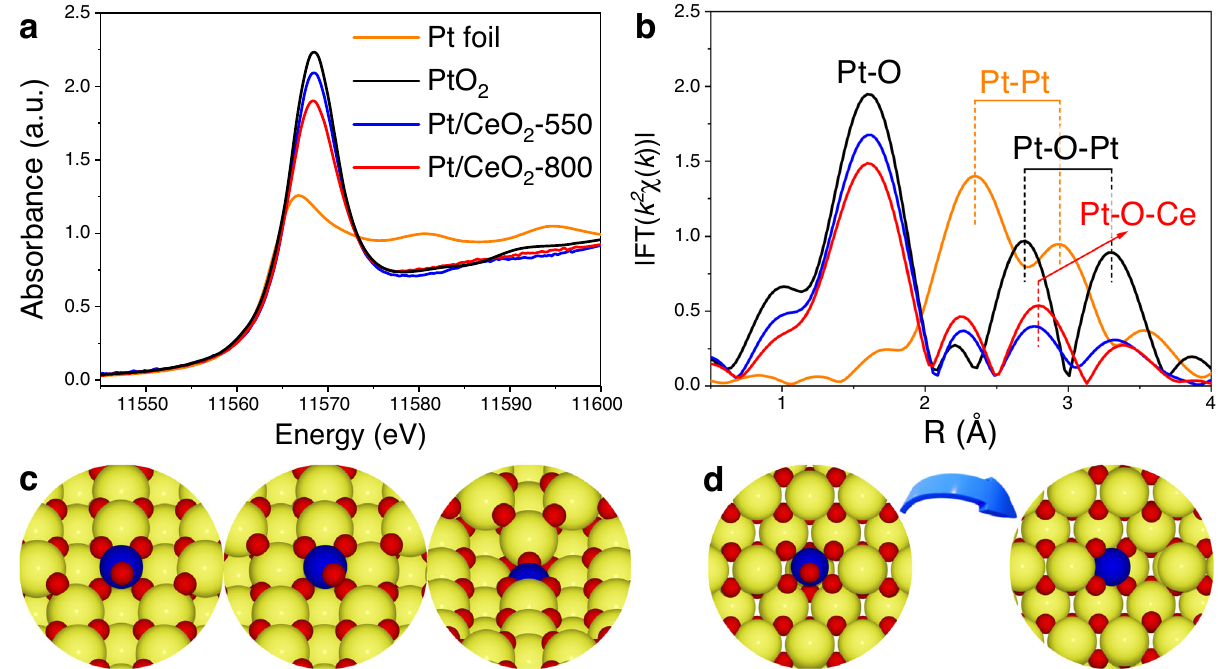
Fig. 4 | Coordination environment of Pt single atoms determined by XAS combination fi tting and EXAFS comparison. c Three possible geometries of Pt analysis.a Normalized XANESand b EXAFS magnitudeof the Fourier transformed single atoms at the edge or step sites on CeO 2 (110) within Pt/CeO 2 -550. d The k 2 -weighted χ ( k ) data for Pt/CeO reconstructionofPtsingleatomsonCeO 2 (110)terrace fromsix-coordinationsites 2 -550 (blue) and Pt/CeO 2 -800 (red) at the Pt-L 3 edge. Pt foil (orange) and PtO 2 (black) references were used for XANES linear to square-planar like coordination sites within Pt/CeO 2